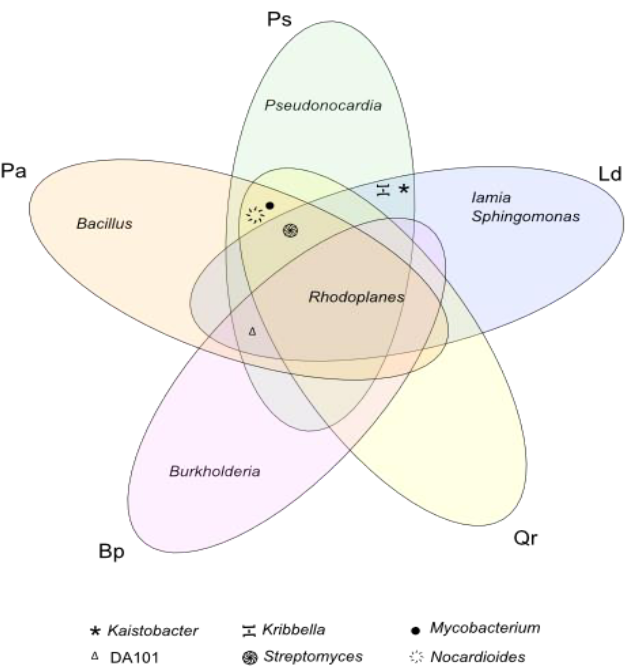
Figure 9. A Venn diagram showing common and unique species of bacteria in forest soils with the difference between the proportions ≥ 1%. Pa— Picea abies L., Ps— Pinus sylvestris L., Ld— Larix decidua M., Qr— Quercus robur L., and Bp— Betula pendula L. The enzymatic activity of the soil sampled from all tree stands was highly diversified (Figure 10 and Table S4 ). All tree species stimulated the activities of dehydrogenases, β - glucosidase, and arylsulfatase. In turn, they had the weakest stimulating effect on the activities of catalase, urease, and acid phosphatase. The activity of alkaline phosphatase was positively affected by all tree species, except for Betula pendula L. Despite various fluctuations, data presented in Figure 8 indicate that Quercus robur L. and Larix decidua